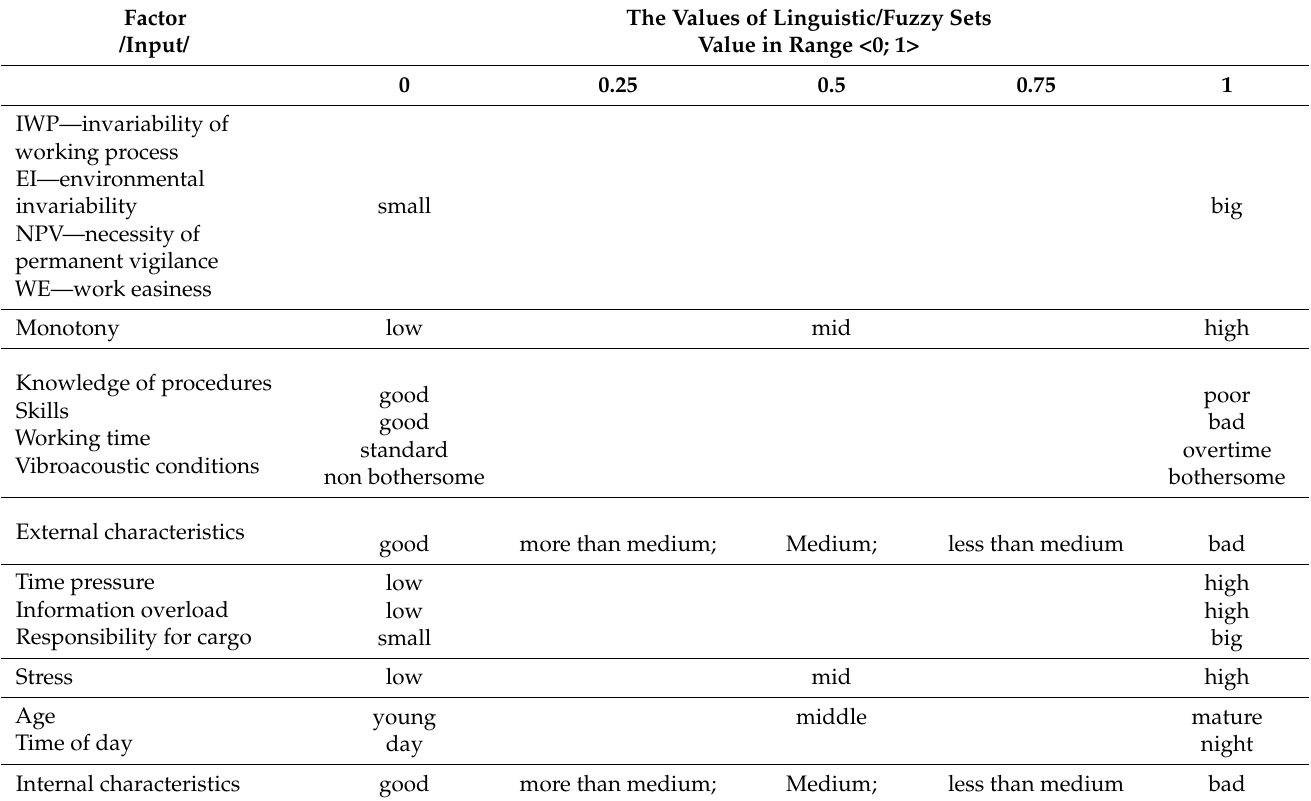
Table 1. Extent of change in the values of the analyzed